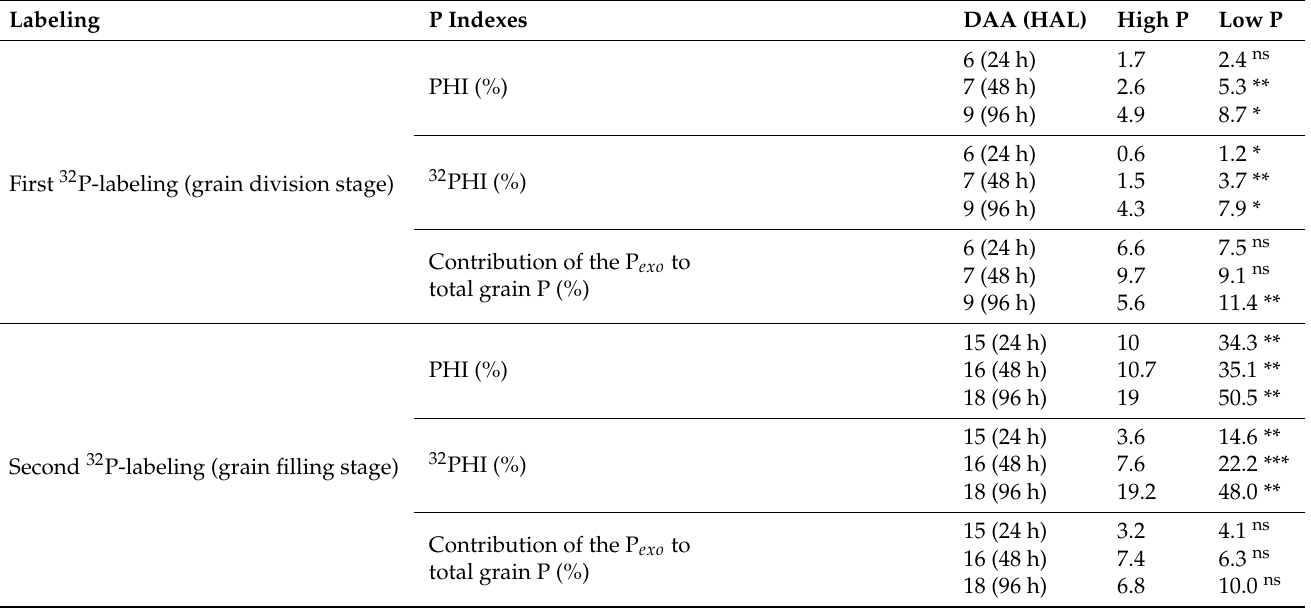
Table 2. Phosphorus harvest index (PHI), 32 PHI, and the contributions of newly acquired P to the accumulated P in the grains of durum wheat grown under high and low P supplies. DAA: day after anthesis. DAL: day after labeling. The asterisks *, ** and *** indicate significant difference at p < 0.05, p < 0.01 and p < 0.001 between high and low P treatments, respectively. ns: not